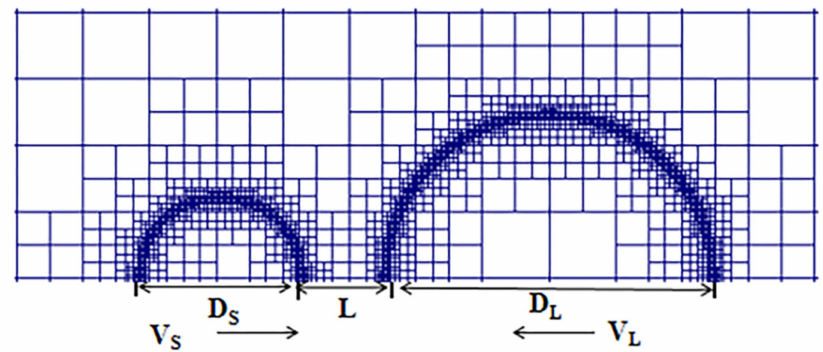
Figure 2. Initial droplets and adaptive mesh.